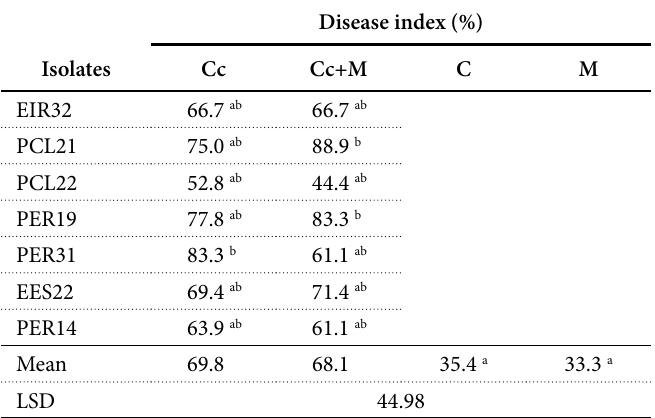
Tab. 2 Disease index (%) of tomato seedlings in the experimental